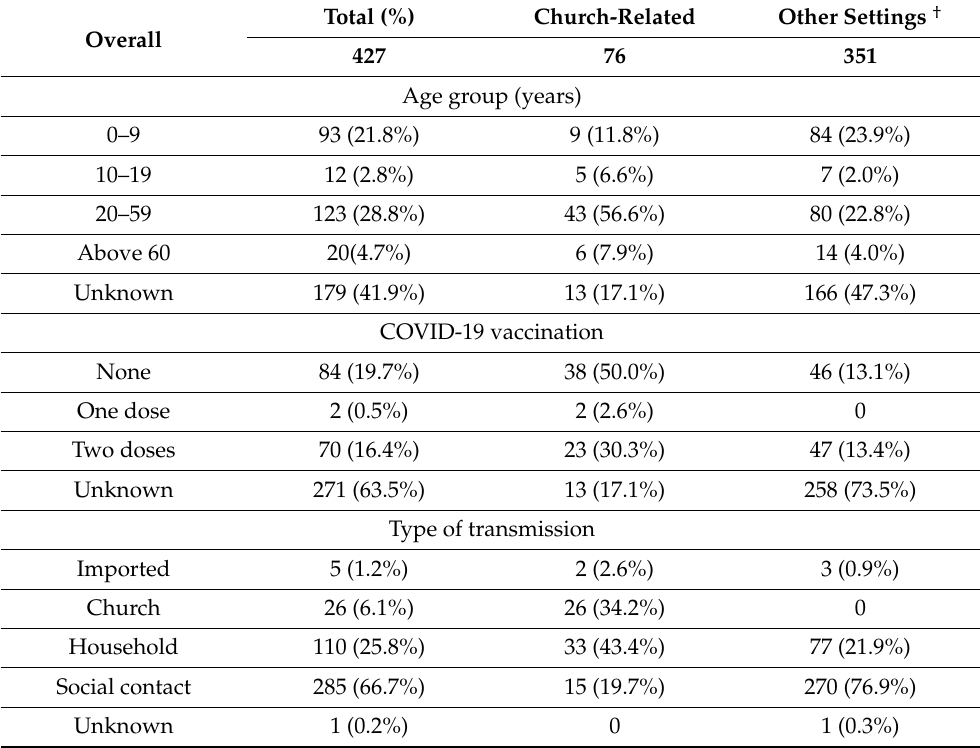
Table 1. Descriptive summary of the demographic and epidemiological characteristics of 427 con- firmed cases of the SARS-CoV-2 omicron variant in South